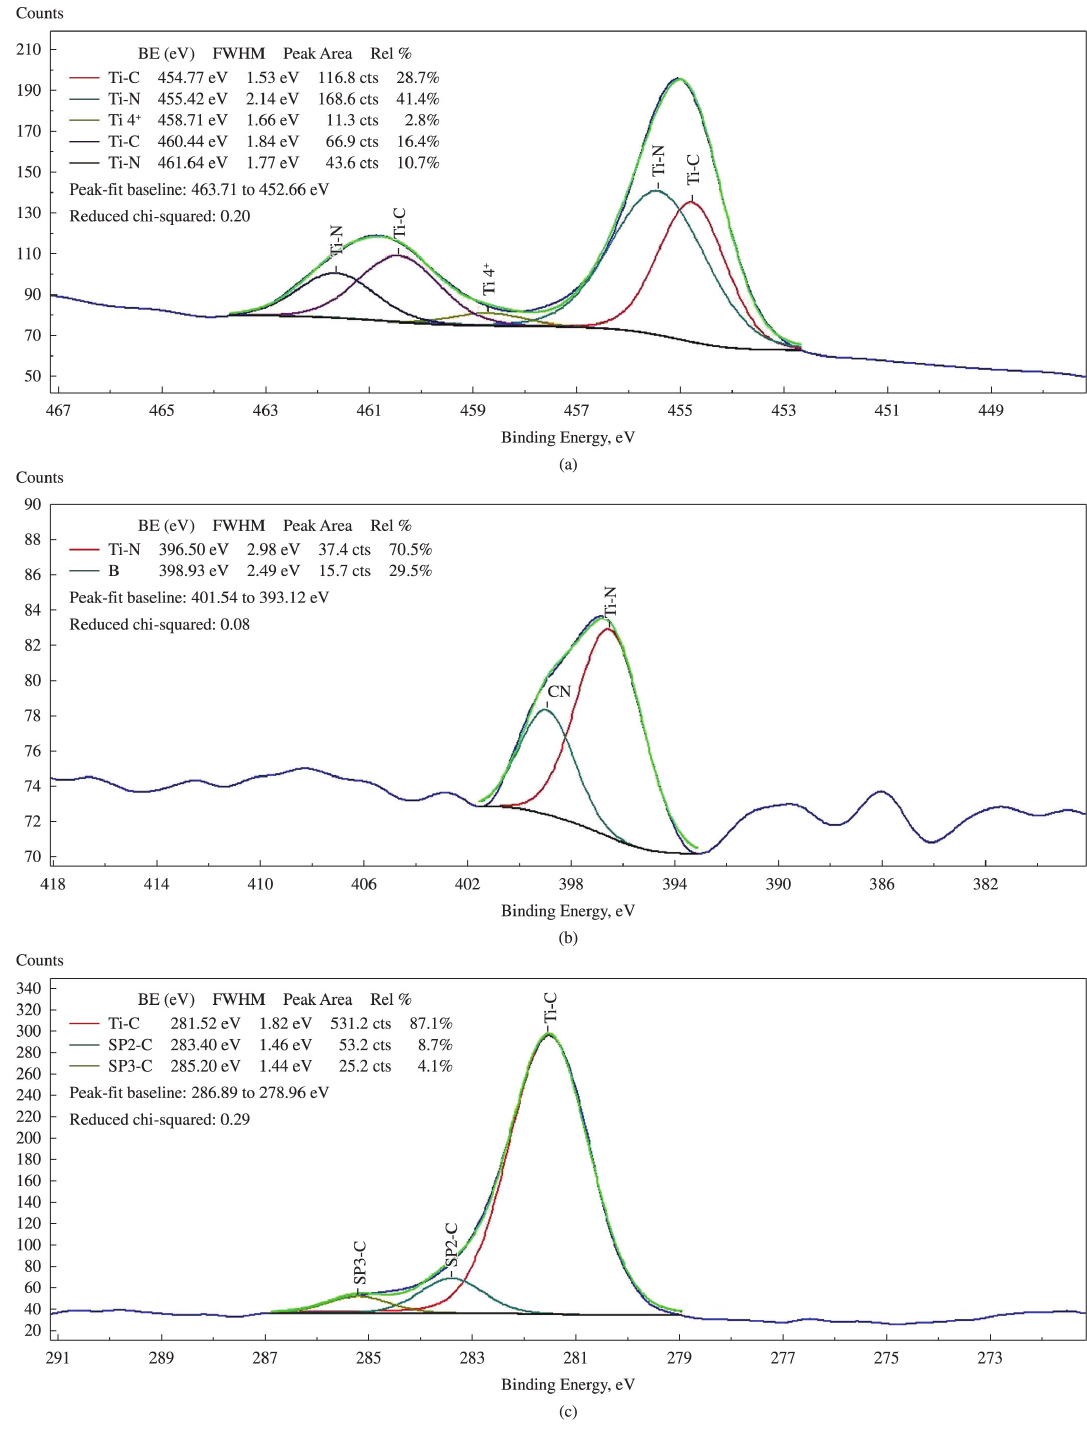
Figure 2. XPS spectra of a)Ti 2p, b)N 1s and c)C 1s for the film for CH4/ (CH4+N2) gas flow ratio